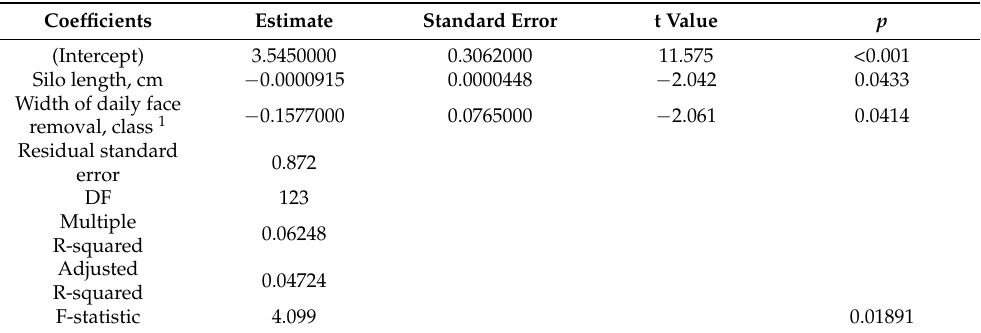
Table 3. Linear regression analysis of the log10 most probable number of spores (MPNld) from each silo, and its structural and management features. Figure 3. Distribution of anaerobic spore-forming bacteria spores (MPN, log 10 n /g) for the three kinds of silo sampled within the study.